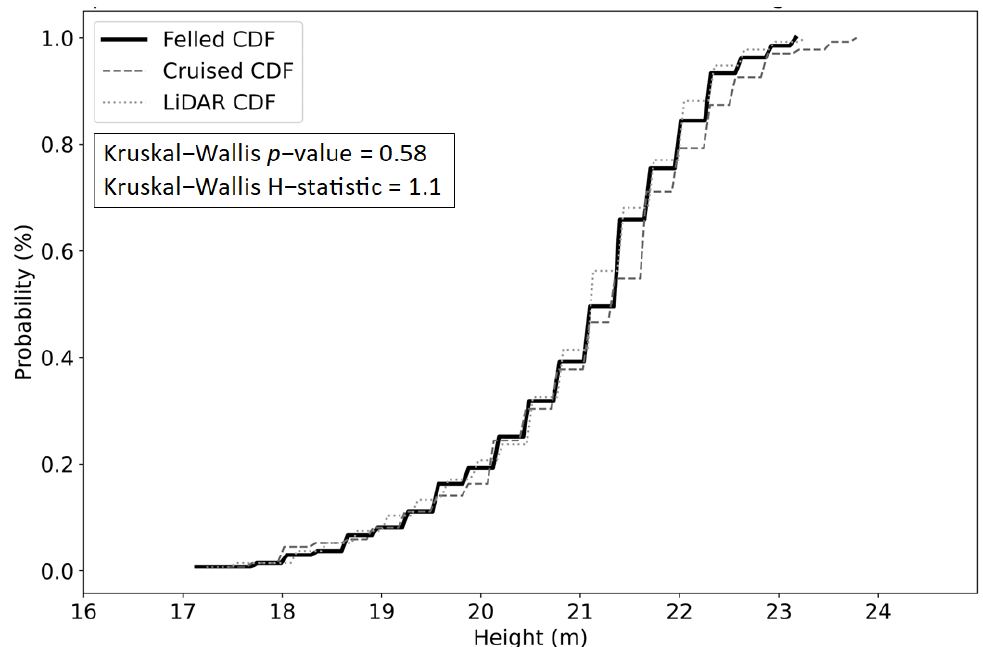
the intercept. The ALS-derived and cruised height are equivalent to the felled height when the ver- tical red bar is completely within the grey polygon. The grey dashed lines represent the ±25% region of equivalence for the slope. If the vertical black bar is within the grey dashed lines, then the regres- sion slope is significantly similar to 1. The solid black line represents the best-fit linear regression model.